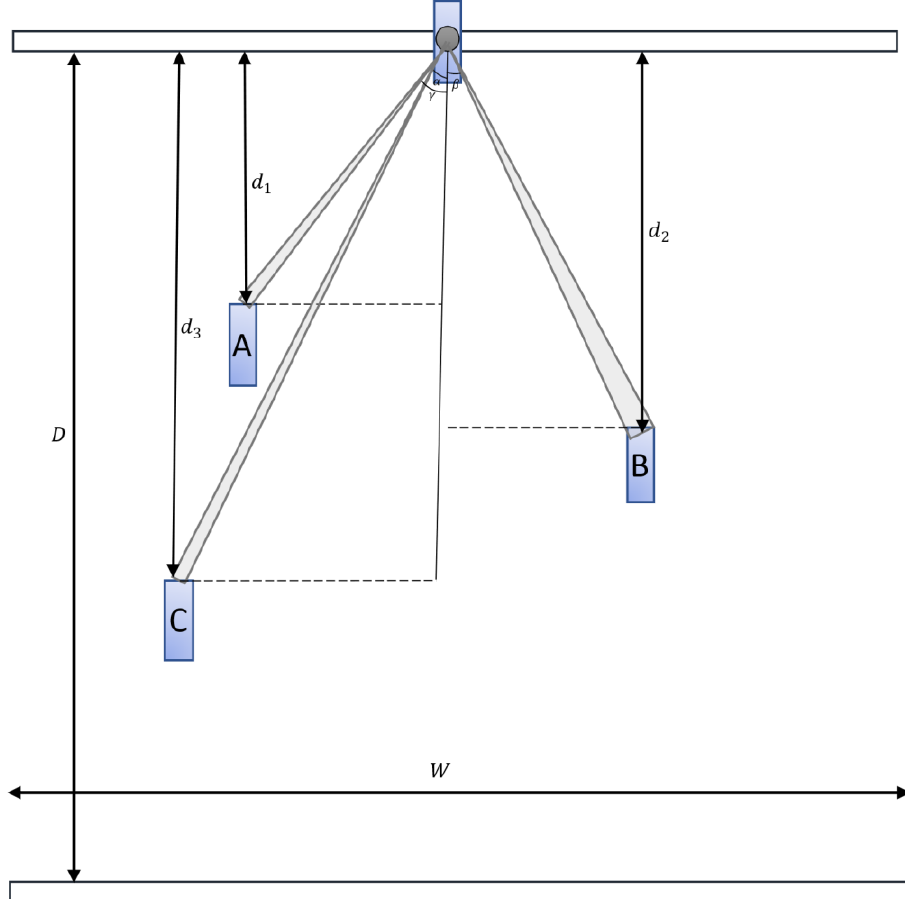
Figure 4. General overview of the distance estimation. A, B, C are the cars located in distances d1, d2, and d3 respectively from the origin by y-axis. and d 3 respectively from the origin by